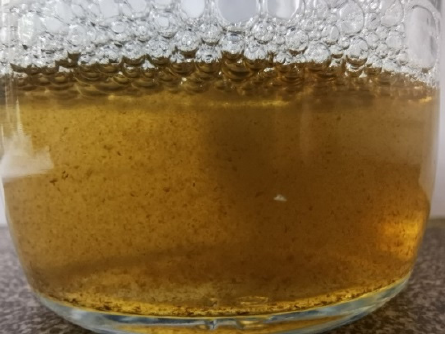
Figure 1. Visible aggregates of GO in RAE liquid medium (at pH = 4.1).